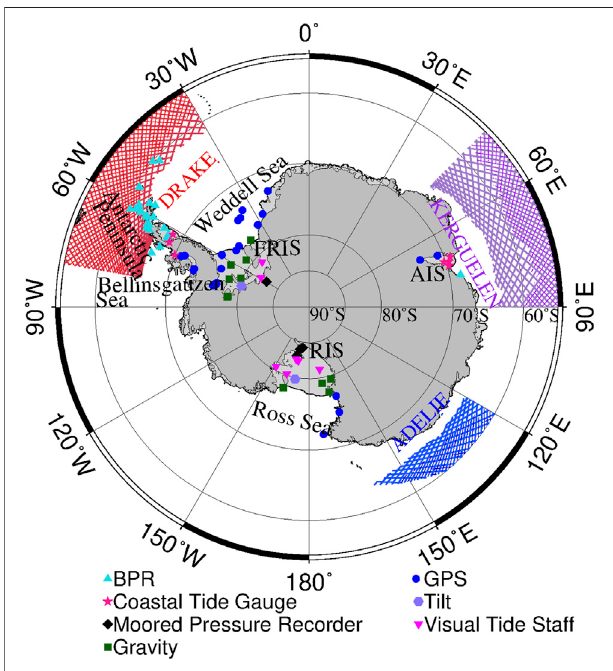
FIGURE 1 | Locations of all tidal measurements and X-Track satellite altimetry track